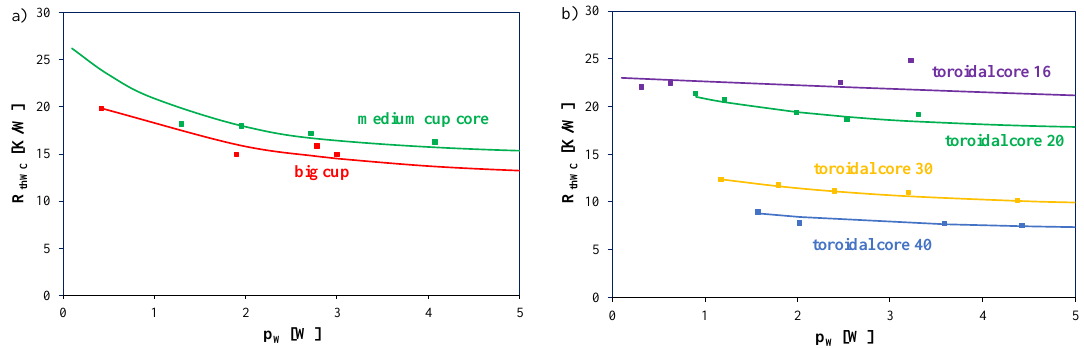
Figure 15. Measured and calculated dependences of thermal resistance R thW of inductors with ( a ) cup cores and ( b ) toroidal core on dissipated power in the winding.